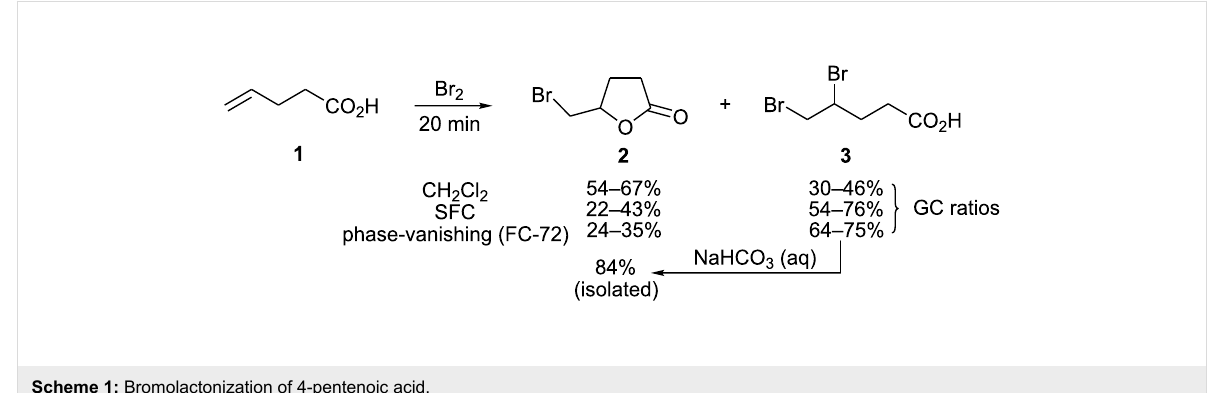
Scheme 1: Bromolactonization of 4-pentenoic